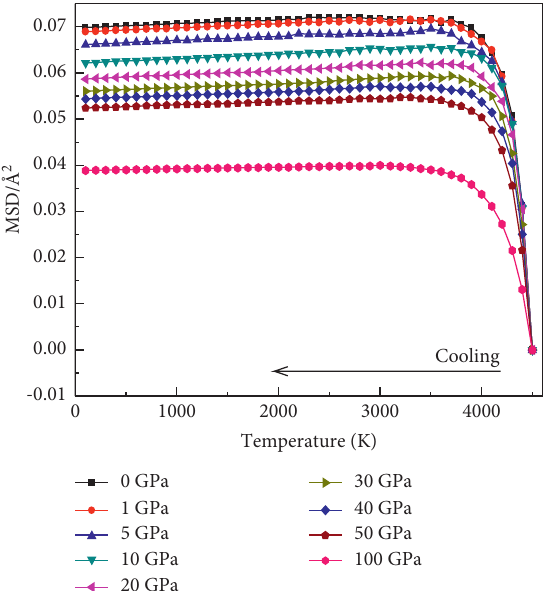
Figure 2: Relationship between MSD and temperature during rapid solidification of SiC under different